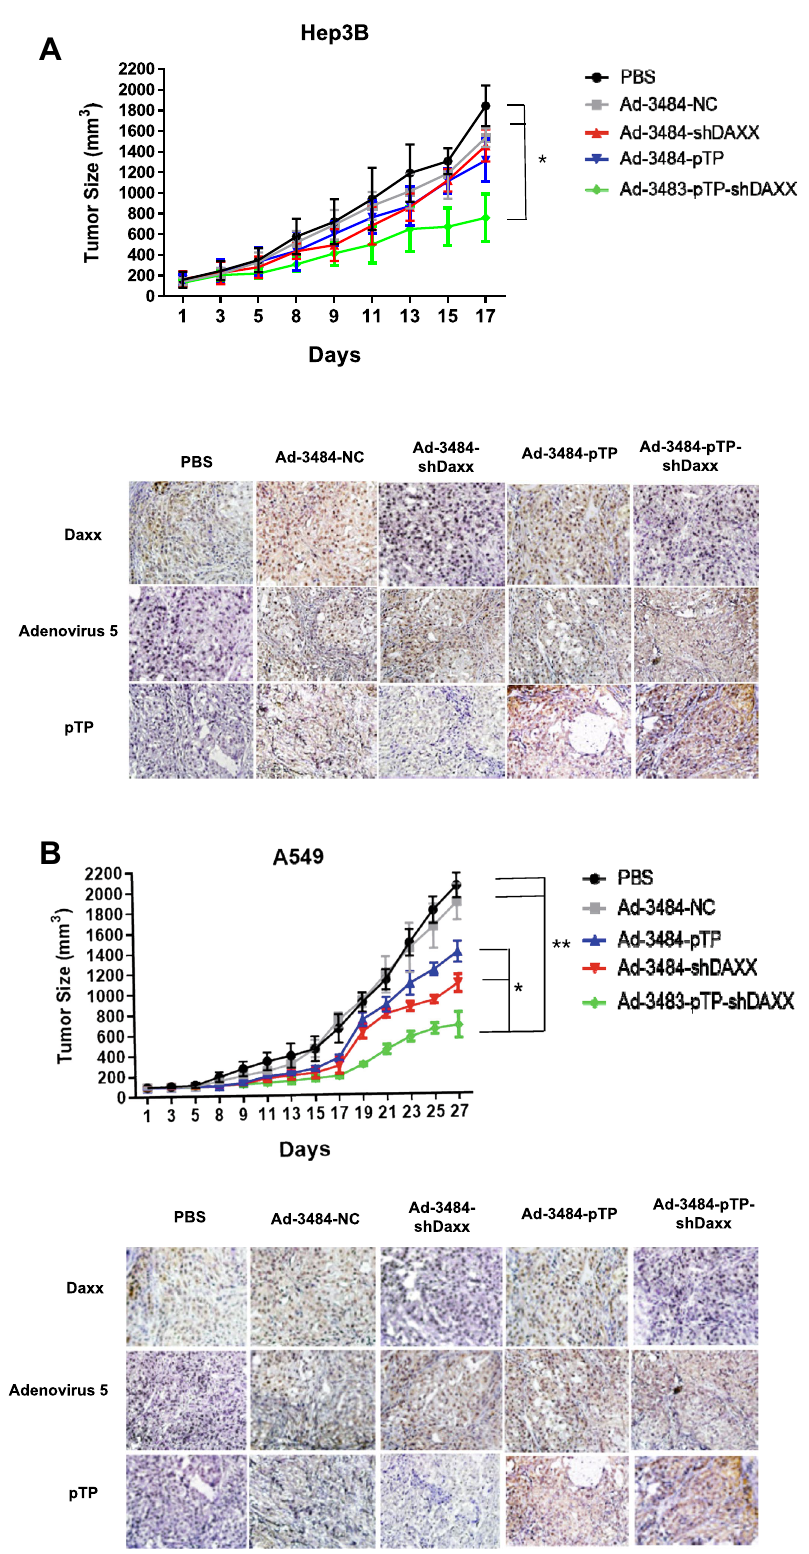
Figure 5. Tumor size measurements and immunohistochemical images of tumors. Hep3B cells ( A ) or A549 cells ( B ) in Matrigel were injected subcutaneously in the abdominal region of BALB/c athymic nude mice, and intratumoral injections of PBS, or of each virus indicated, were repeated every other day for a total of three injections. Tumor volume was measured and calculated on the indicated days using the following formula: Volume (mm 3 ) = 0.52 × (Length) × (Width) 2 (n = 5 per group) (upper). Error bars represent standard error from five mice in each experimental group. The asterisk indicates a significant difference between each comparative group (* P < 0.05; ** P < 0.01). Tumor tissues after euthanasia from each group (n = 2 per group) for immunohistochemistry were harvested 7 days following virus infections. Adenovirus 5, pTP or Daxx primary antibodies were incubated overnight at 4 °C on tissue slides. Images were obtained by light microscopy (200×).